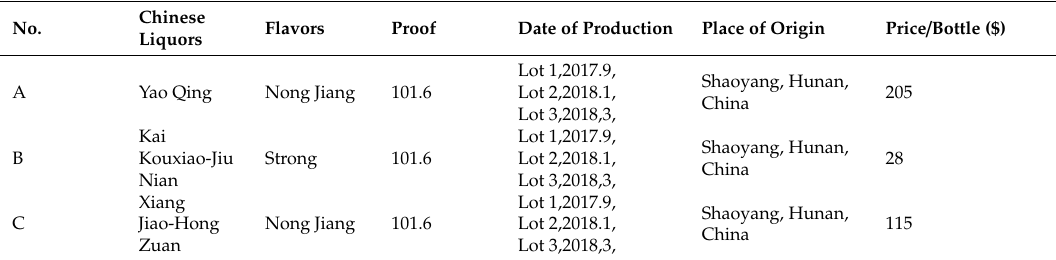
Table 4. The details of Chinese liquors in the